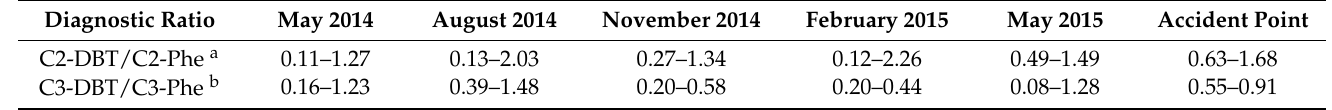
Table 8. Selected source diagnostic ratios for source identification.